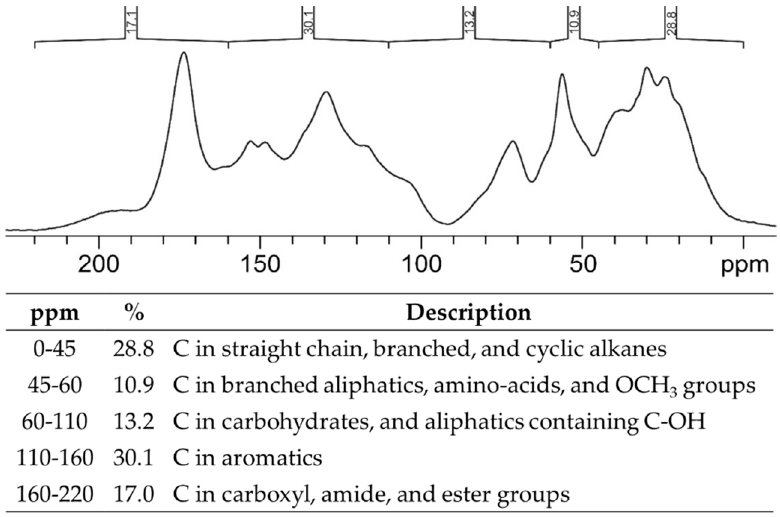
Figure 2. 13 C CPMAS solid-state NMR spectrum of BBS-HA ( top ), assignments and relative area calculated from the NMR spectrum ( bottom ).